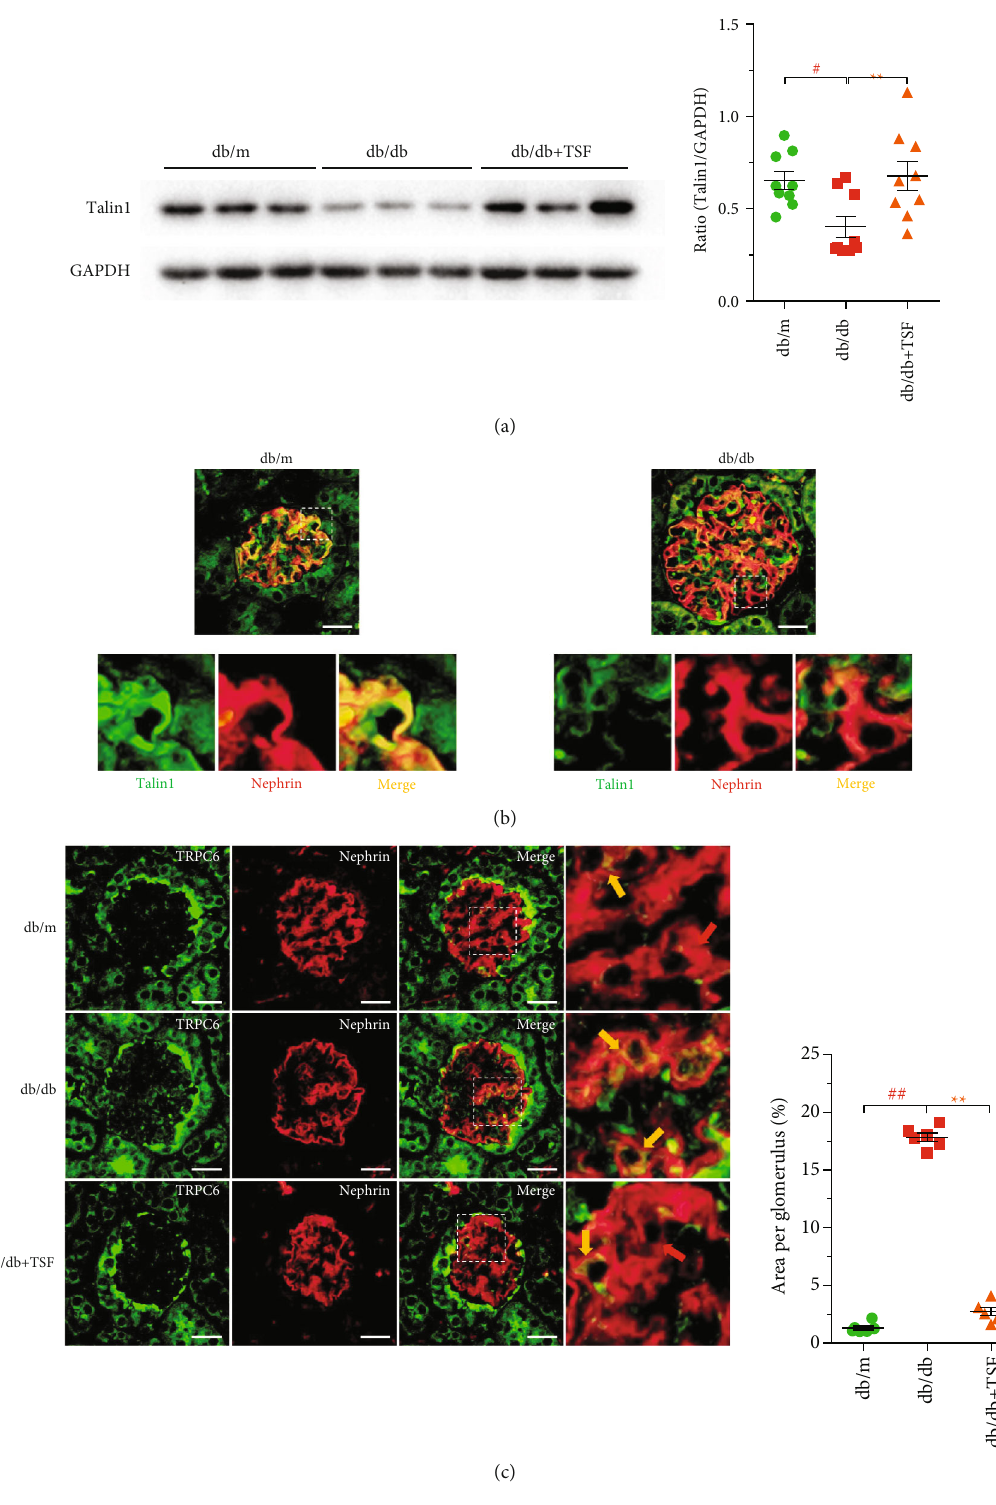
Figure 3: TSF protects podocyte-associated protein talin1 in db/db mice, which may involve increased expression of TRPC6 in podocytes. (a) Immunoblotting and quantitative analysis of talin1 ( n = 3 experiments). (b) Immuno fl uorescence costaining (scale bars, 25 μ m) of nephrin (red) and talin1 (green) showed that talin1 had a speci fi c deletion in podocytes. (c) Immuno fl uorescence costaining (scale bars, 25 μ m) of nephrin (red; red arrow) and TRPC6 (green) showed that increased expression of podocyte TRPC6 in db/db mice (yellow arrow) compared to db/m mice and db/db + TSF mice ( n = 6 ). Fluorescent images were collected and assessed using a high-content screening system. The data were expressed as the mean ± SEM . # P < 0 : 05 , ## P < 0 : 01 vs. db/m group; ∗ P < 0 : 05 , ∗∗ P < 0 : 01 vs. db/db group. Statistically analyzed via a one-way ANOVA with Dunnett ’ s